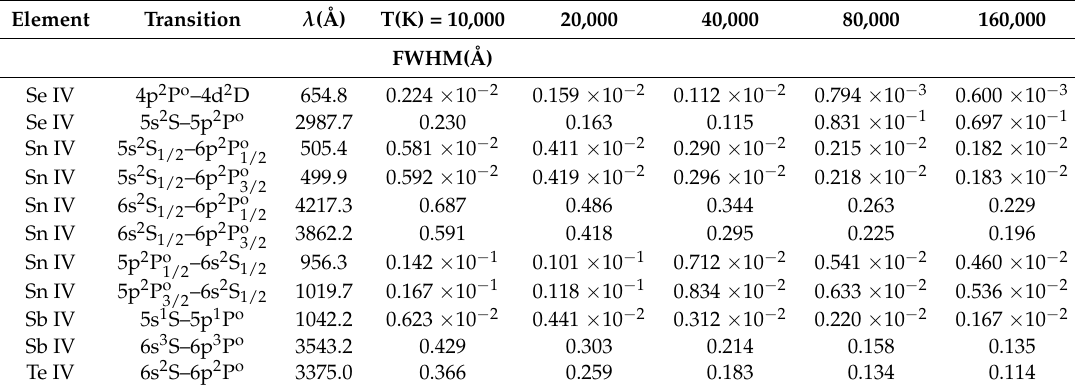
Table 1. FWHM - Full Width at Half intensity Maximum (Å) for Se IV, Sn IV, Sb IV and Te IV spectral lines, for a perturber density of 10 17 cm − 3 and temperatures from 10,000 to 160,000 K. Calculated wavelength ( λ ) of the transitions (in Å) is also given.